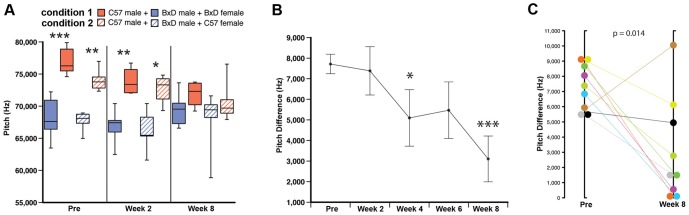
Pitch convergence in B6+BxD male pairs housed with either a B6 or BxD female.
A, Box plots of Type A syllable pitch from the songs of B6 and BxD males before and over 8 weeks of cross-strain paired housing with either a BxD female (solid boxes) or B6 female (striped boxes) (* = p<0.05; ** = p<0.01; *** = p<0.001; Mann-Whitney U-test; n = 4–7 per time point depending on obtaining a sufficient amount of song). Box plots show the median, 1st and 3rd quartile, and full range. B, The mean pitch difference of Type A syllables between the two males in each B6-BxD pair before and over 8 weeks of cross-strain paired housing (* = p<0.05; *** = p<0.001; Student's t-test; Pre: n = 12; Week 2: n = 9; Week 4: n = 6; Week 6: n = 8; Week 8: n = 9; data are plotted as means ± s.e.m.) C, Same pre and post data as in (B), but plotted for individual pairs from before (Pre) and at 8 weeks after cross-strain paired housing (p-value reported on the graph; paired Student's t-test; n = 9). Data are from an average of 616±84 s.e.m. Type A syllables per animal per week.